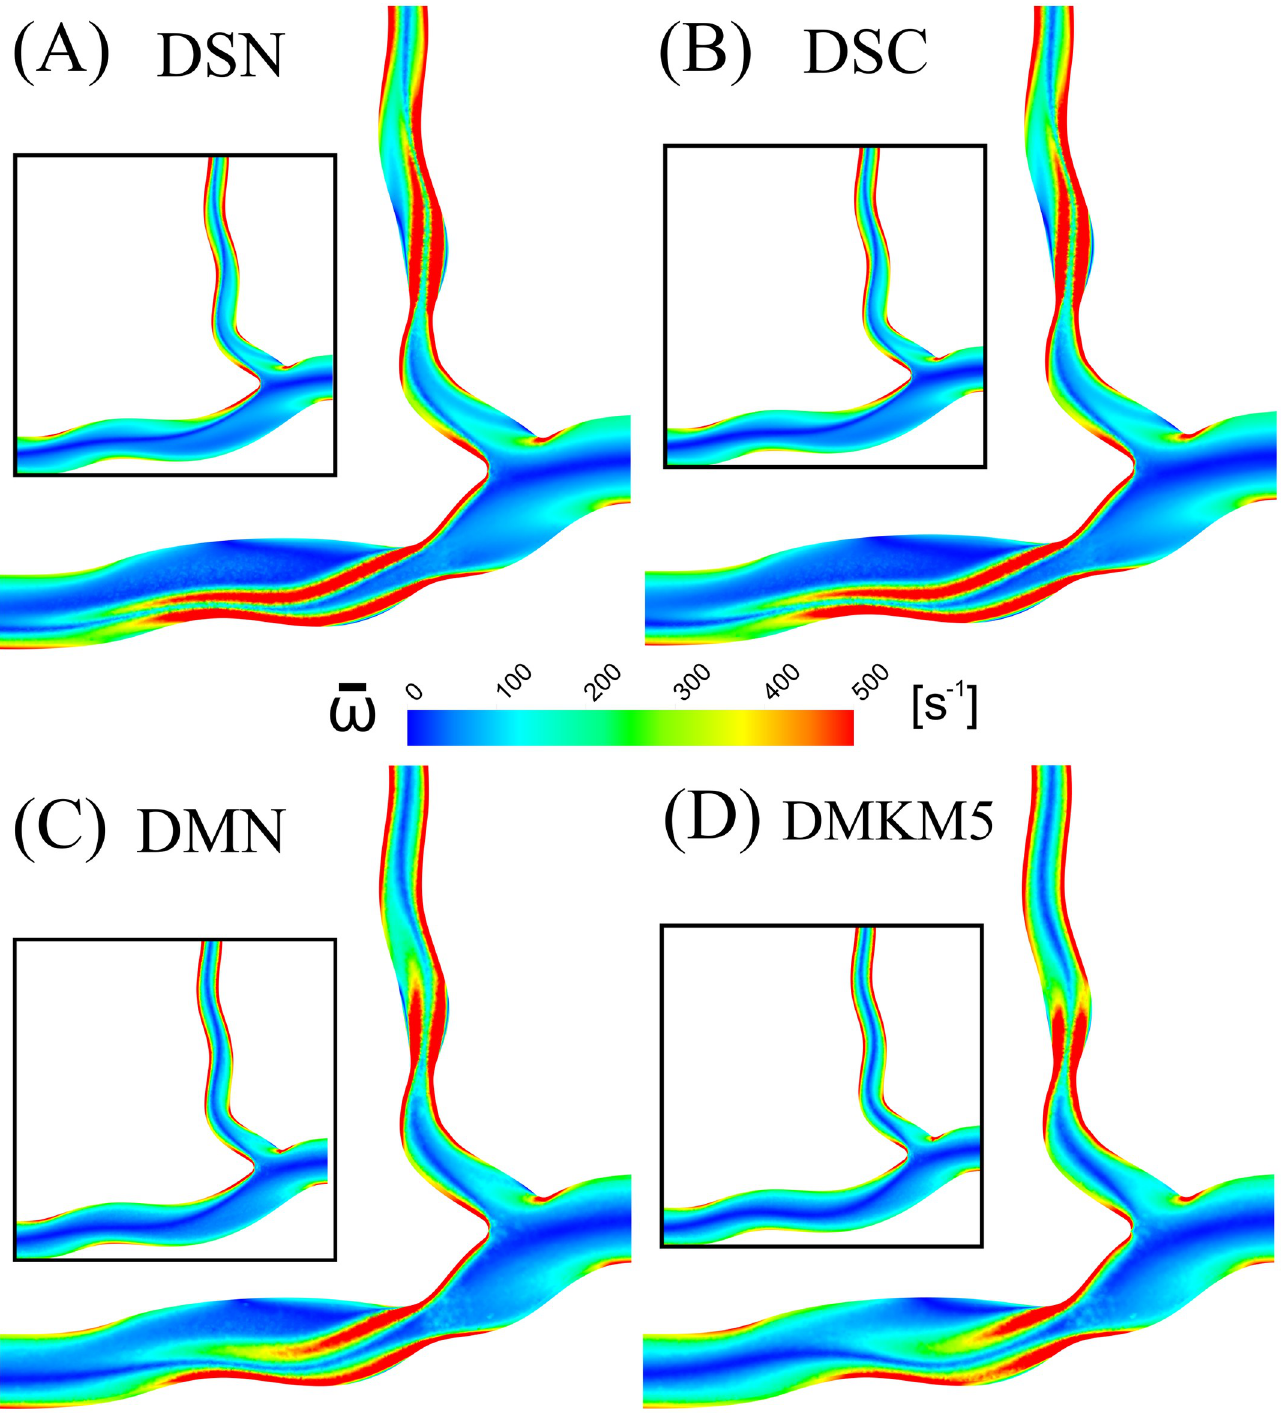
Fig 8. Mid-plane cross section of time averaged blood vorticity for the diseased artery: (A) Single-Newtonian, (B) Single-Carreau, (C) Multi-Newtonian and (D) Multi-MKM5 models. Results for the healthy artery are inlaid as